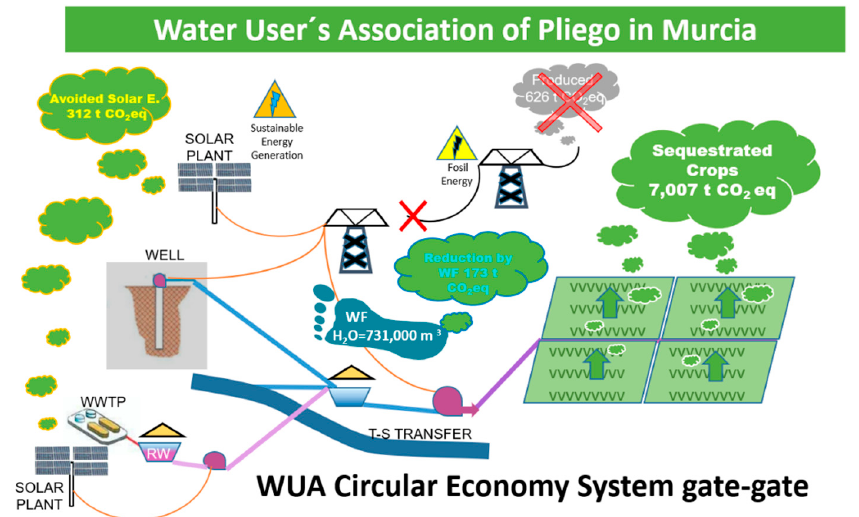
Figure 11. Summary of the environmental effects generated in the WUA. Source: Own elaboration.